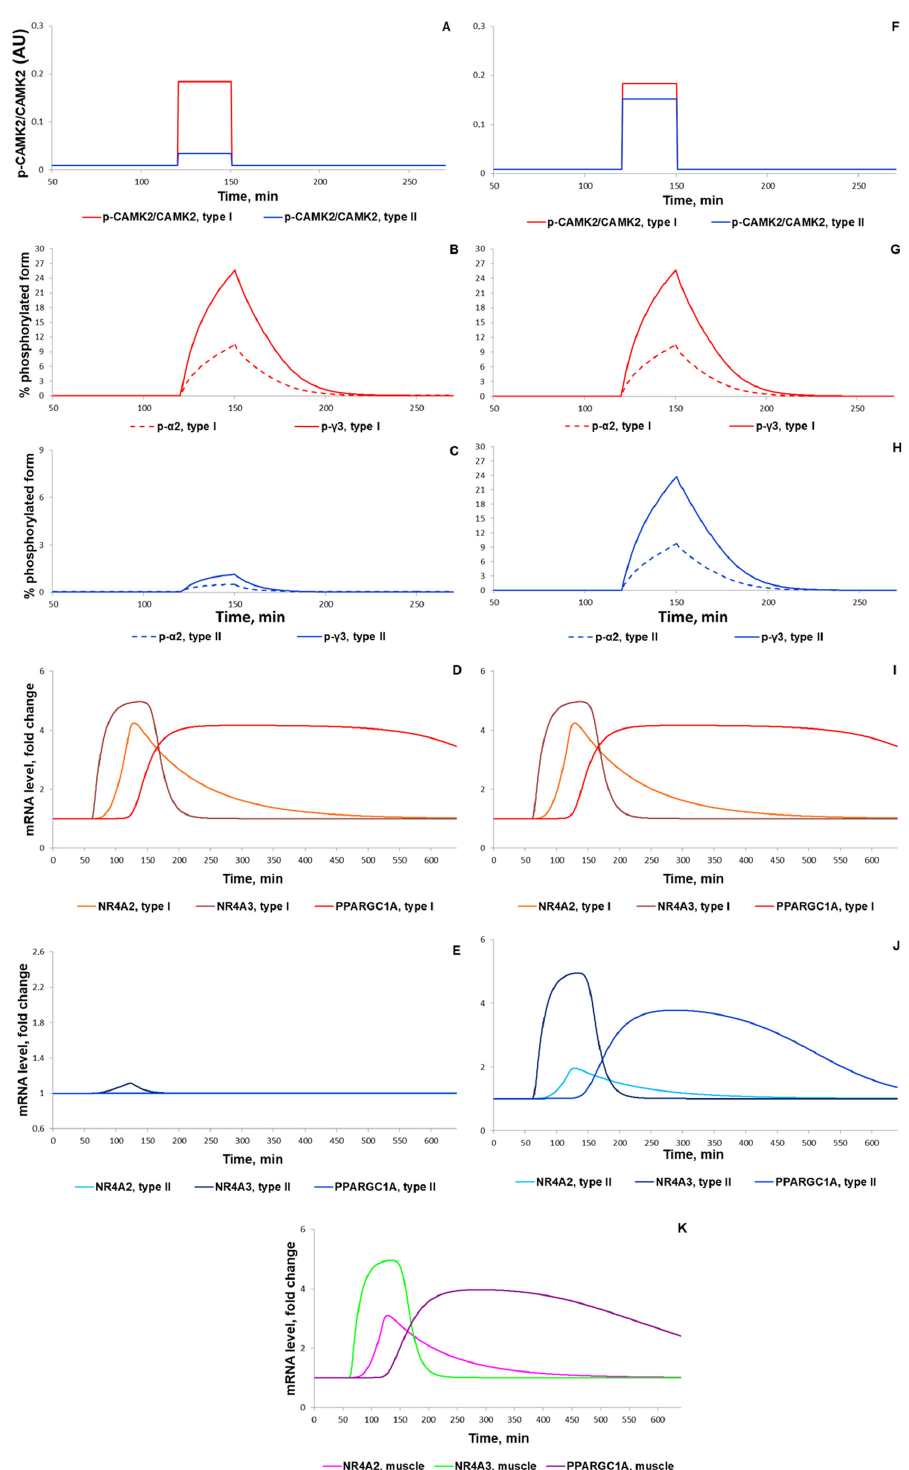
Figure 12. Simulation results for low and moderate intensity (50% ( A – E ) and 70% ( F – K ) VO2 max , respectively) continuous exercises (30 min for signaling and 60 min for gene expression) with intermediate X factor regulating the expression of the PPARGC1A gene. ( A , F ) Ratio of CAMKII phosphorylated protein in type I (red) and type II (blue) fibers (corresponds to [53]); ( B , C , G , H ) Percentage of all α 2 phosphorylated proteins (dashed) and of the phosphorylated γ 3 heterotrimers (solid) in type I fibers and type II fibers, respectively (corresponds to [65,96]); ( D , I ) Expression (in fold changes) of NR4A3 (thunderbird solid), NR4A2 (orange solid), PPARGC1A (red solid) in type I fibers and ( E , J ) in type II fibers, where NR4A3 —sapphire solid, NR4A2 —azure solid, PPARGC1A —blue solid; ( K ) Expression (in fold changes) of NR4A3 (green solid), NR4A2 (magenta solid), and PPARGC1A (purple solid) in the muscle tissue during moderate intensity